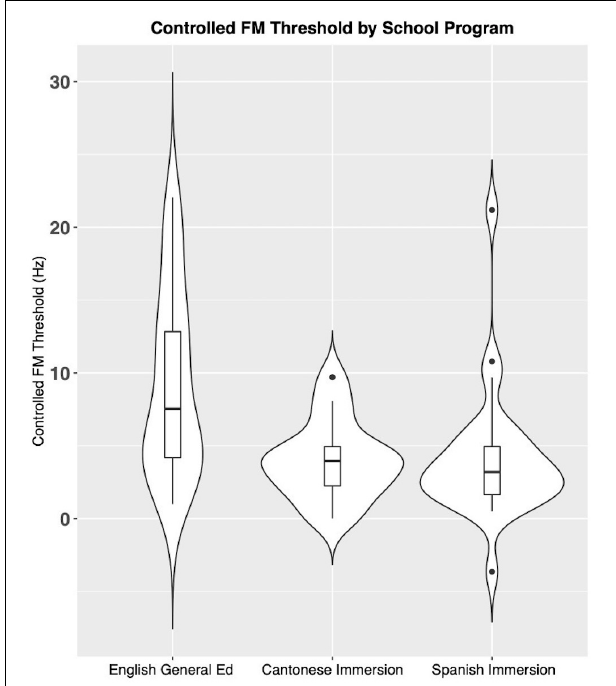
FIGURE 1 | Mean values of controlled FM detection threshold (Hz) across each school program. Lower values indicate better performance. A significant group difference was found ( H 2 , 72 = 15.31, p = 0.00047).